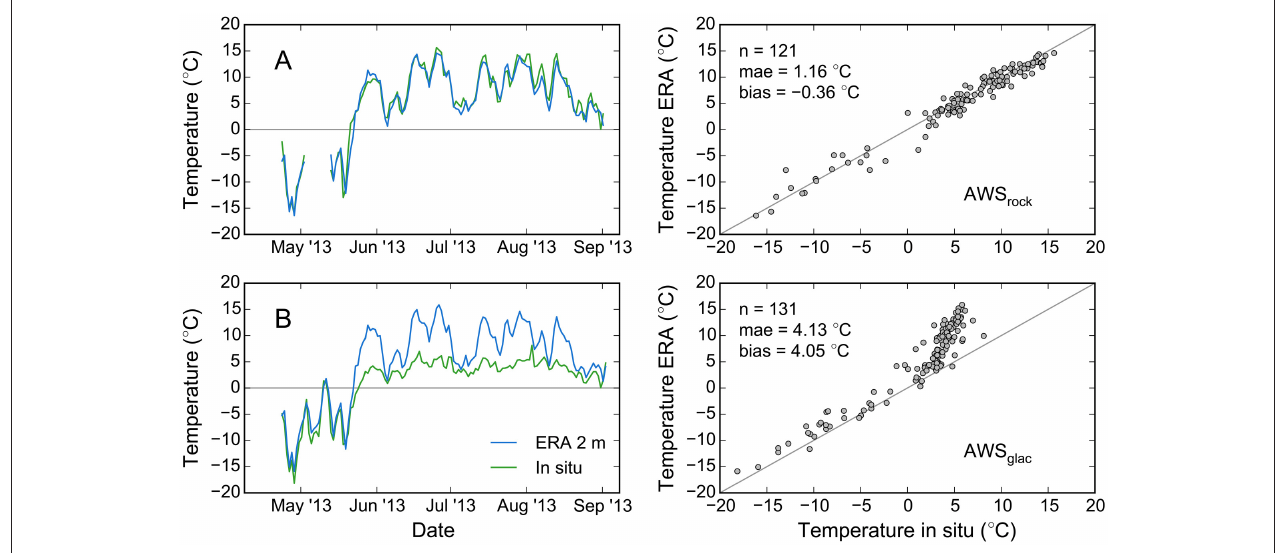
FIGURE 5 | Daily average in situ air temperatures vs. downscaled ERA-Interim near-surface (2 m) temperatures for (A) the off-ice station AWS rock and (B) the on-ice station AWS glac (Figure 1) during the 2013 season. Results are similar for the 2012 and 2014 season. The off-ice station had a measurement gap in May